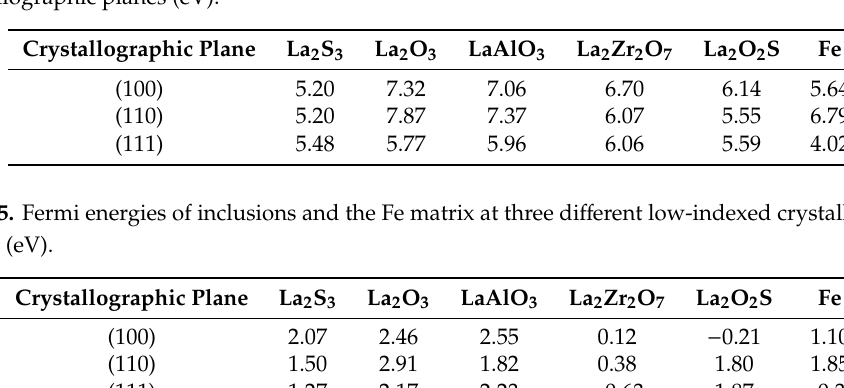
Table 4. Vacuum static potentials of inclusions and the Fe matrix at three di ff erent low-indexed crystallographic planes (eV).